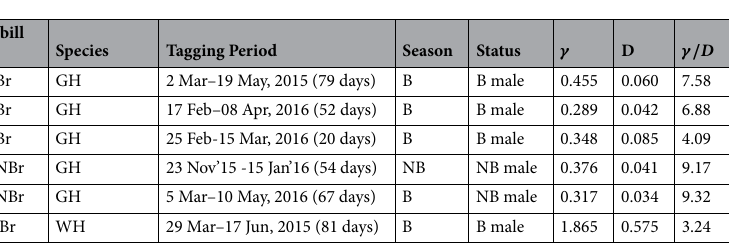
Table 1. Estimated drift ( γ ) and diffusion ( D ) coefficients for hornbills. B denotes breeding, NB denotes non- breeding, GH stands for Great hornbill, WH for Wreathed hornbill. GH2NBr (an adult non-breeding male) was tagged in the non-breeding season, the younger non-breeding male GH5NBr was tagged in the breeding season.